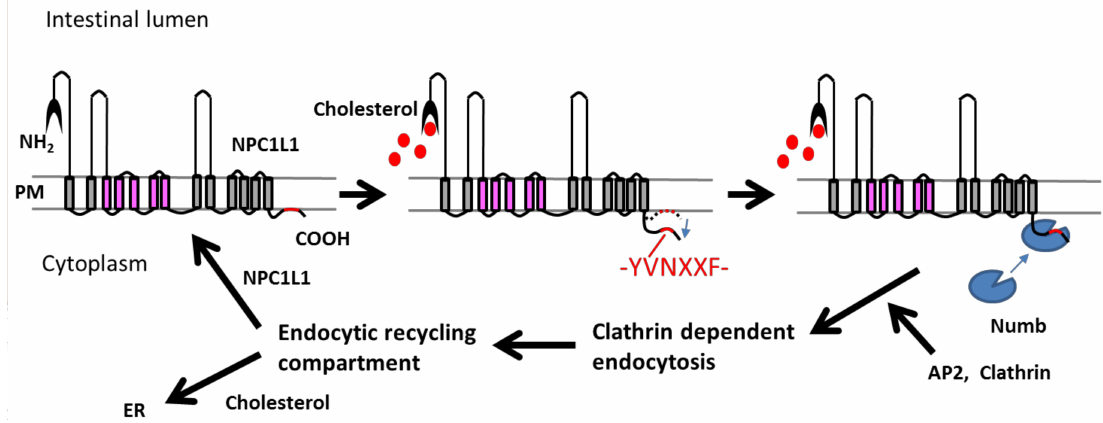
Figure 1. The clathrin-related endocytosis cholesterol transport mechanisms of Niemann–Pick C1-like 1. Modified from Li et al.,